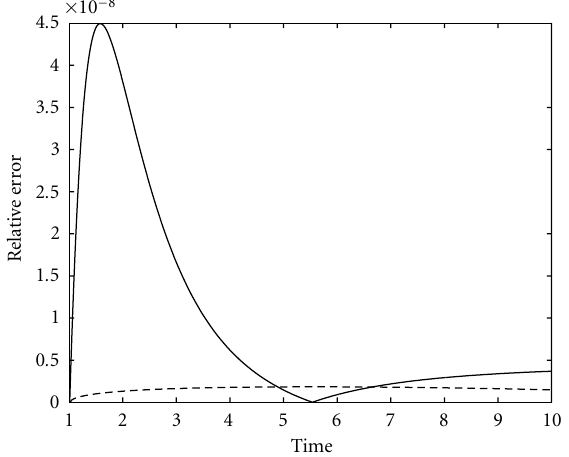
Figure 3.2. The solid line shows the accelerated RK3 scheme given in (2.9b) for (3.2). The dashed line is for the standard RK3 algorithm that uses three function evaluations per